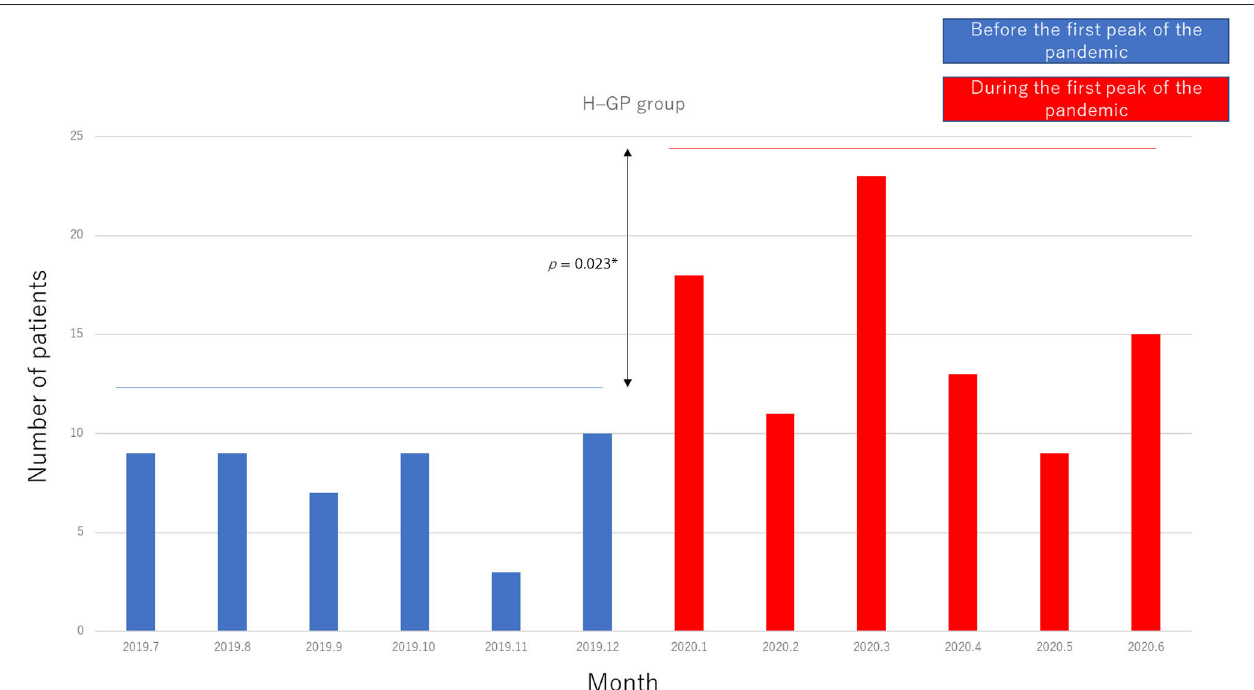
FIGURE 3 | Patient flow from our hospital to general physicians (H–GP group).